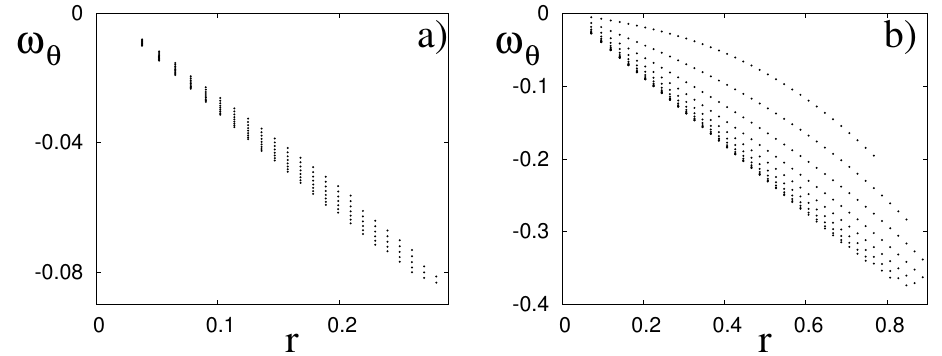
Figure 7. Scatter plots of the azimuthal vorticity ω θ versus the radial coordinate r in the region of the recirculation bubble: ( a ) Γ = 1, Re = 10; ( b ) Γ = 1, Re = 50.